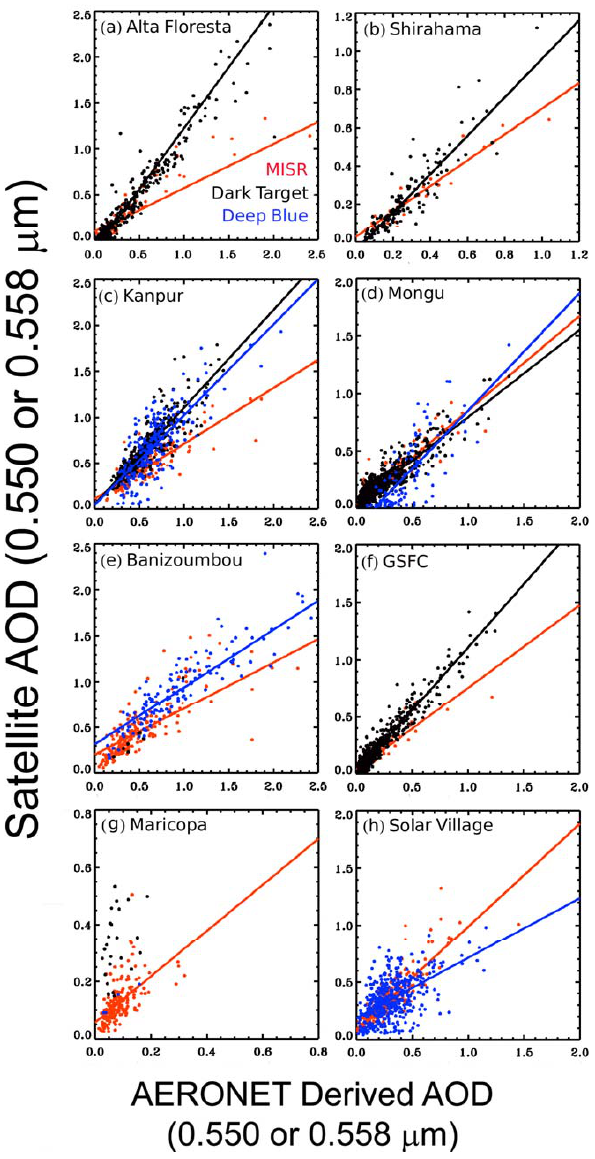
Fig. 1. One to one comparisons between MODIS Dark Target (MODIS Deep Blue)/MISR and AERONET AOD at seven sites for year 2000–2008. (a) Alta Floresta, (b) Shirahama, (c) Kanpur, (d) Mongu, (e) Banizoumbou, (f) GSFC, (g) Maricopa, (h) Solar